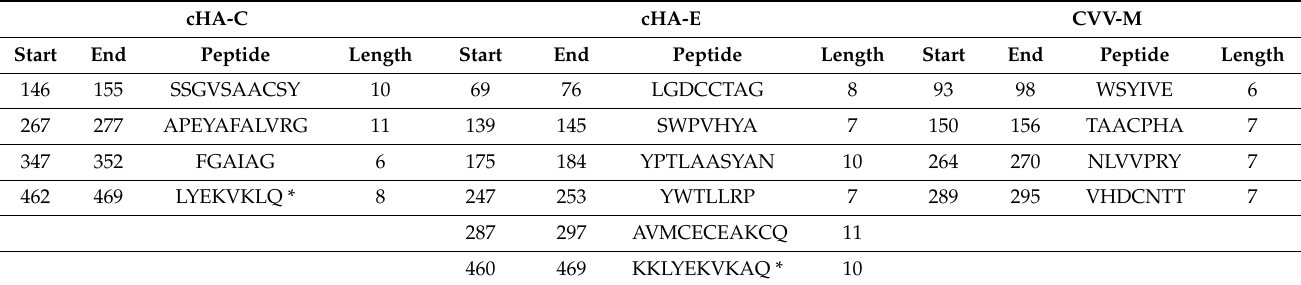
Table 2. Unique and shared epitopes in the H1